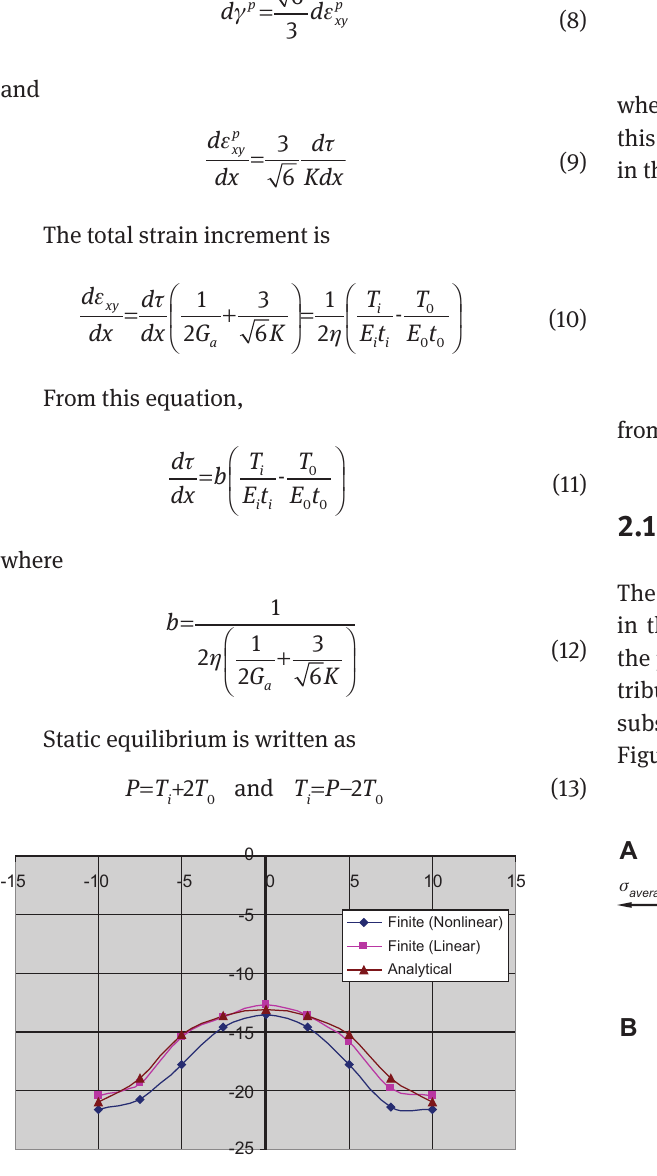
= 3.2 mm. Figure 6 Outer adherend. (A) Stresses, (B) element 0